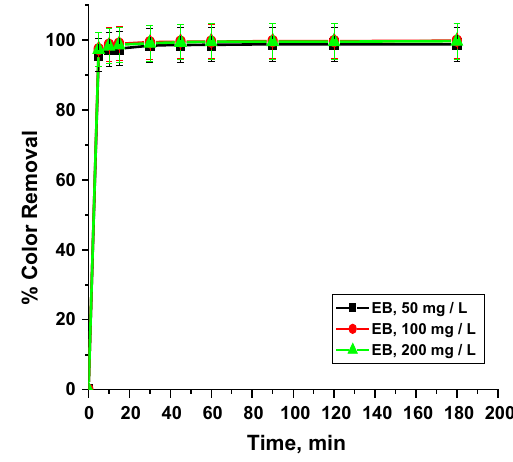
Fig. 5 Effect of contact time on removal of EB (dye concentration: 50, 100 and 200 mg/L, biomass: 100 mg) Fig. 6 Effect of modified biomasses on sorption of EB (dye concentration: 100 mg/L, biomass: 100 mg, 2